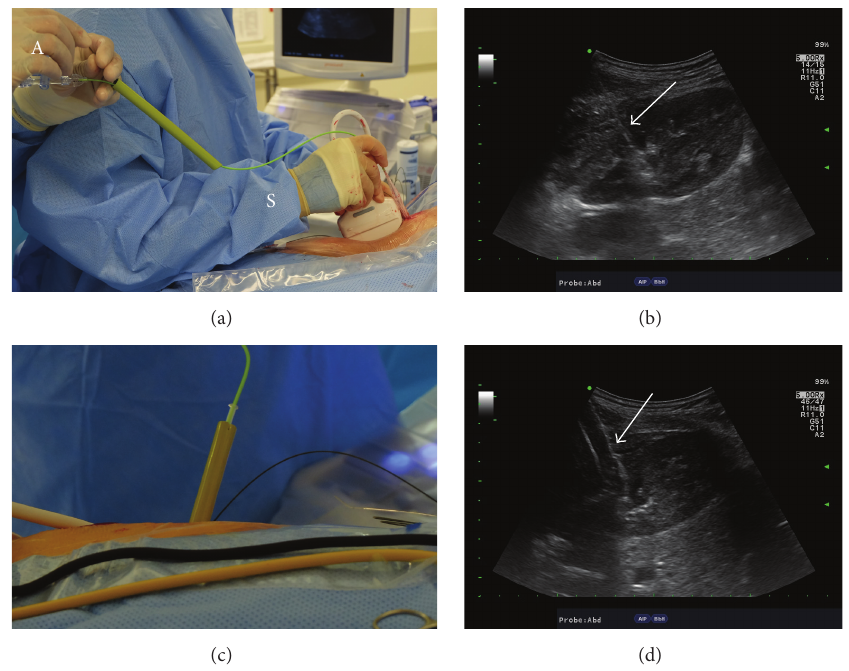
Figure 3: Tract dilation with high-pressure balloon under ultrasound guidance. (a) The deflated balloon dilator is inserted over a working wire and for this step, the operative surgeon (S) controls the ultrasound probe and distal end of the balloon while the assistant (A) controls the wire on the proximal end of the balloon dilator. (b) Ultrasonographic image of the kidney along its longitudinal axis demonstrates that the tip of the deflated balloon dilator (white arrow) is difficult to visualize and differentiate from the wire. (c) The sheath has been inserted over the inflated balloon dilator that is subsequently withdrawn. (d) The inflated balloon (white arrow) can be readily seen with ultrasound